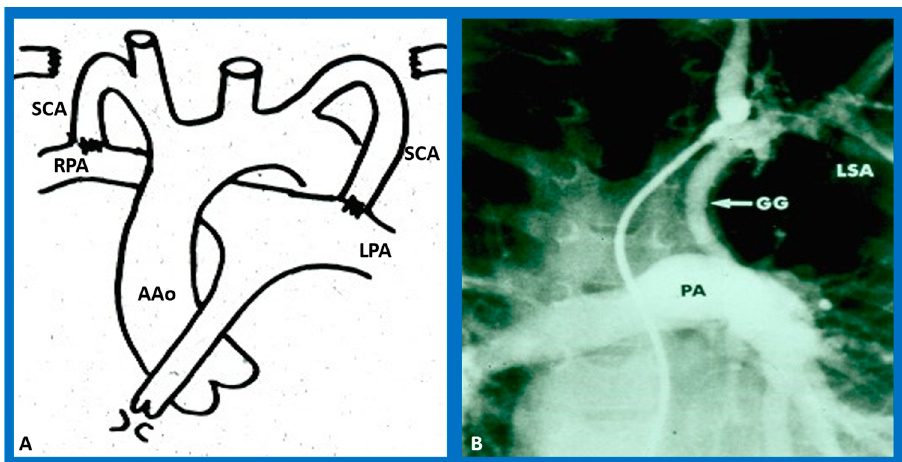
Figure 1. ( A ) The diagram drawn by hand by Dr. Taussig herself demonstrating the idea of the Blalock–Taussig shunt [9] indicating the connection of subclavian arteries (SCAs) to the right (RPA) or left (LPA) pulmonary artery, correspondingly. ( B ) Selected cineangiographic frame of a modified Blalock–Taussig anastomosis with a Gore-Tex graft (GG) connecting the left subclavian artery (LSA) with the pulmonary artery (PA) [10]. This figure reveals a wide-open Blalock–Taussig anastomosis and good opacification of the PA. AAo, ascending aorta. Reproduced from [20].